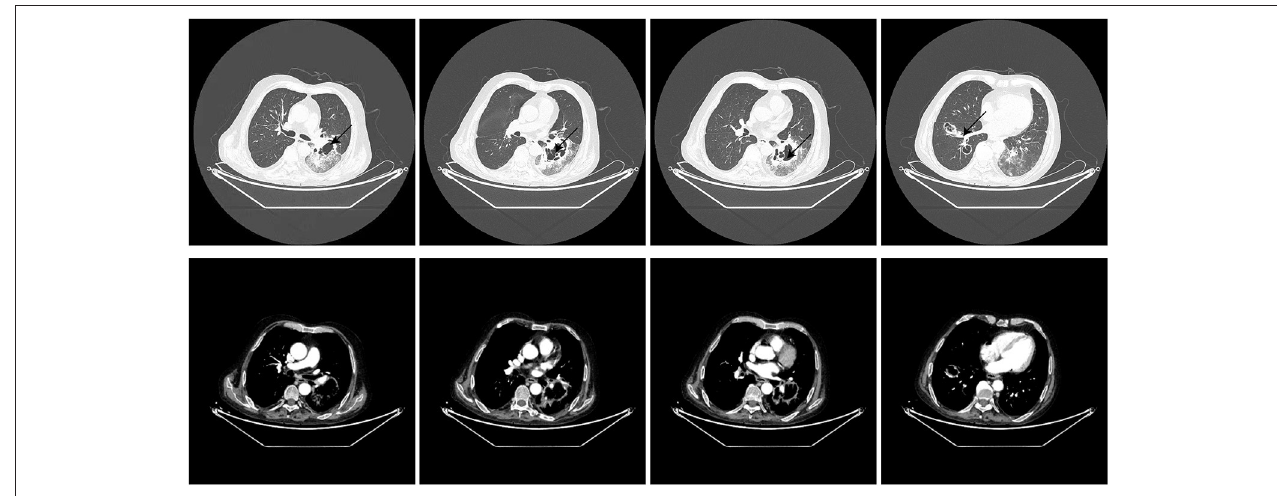
FIGURE 1 | Chest CT upon admission to the hospital.